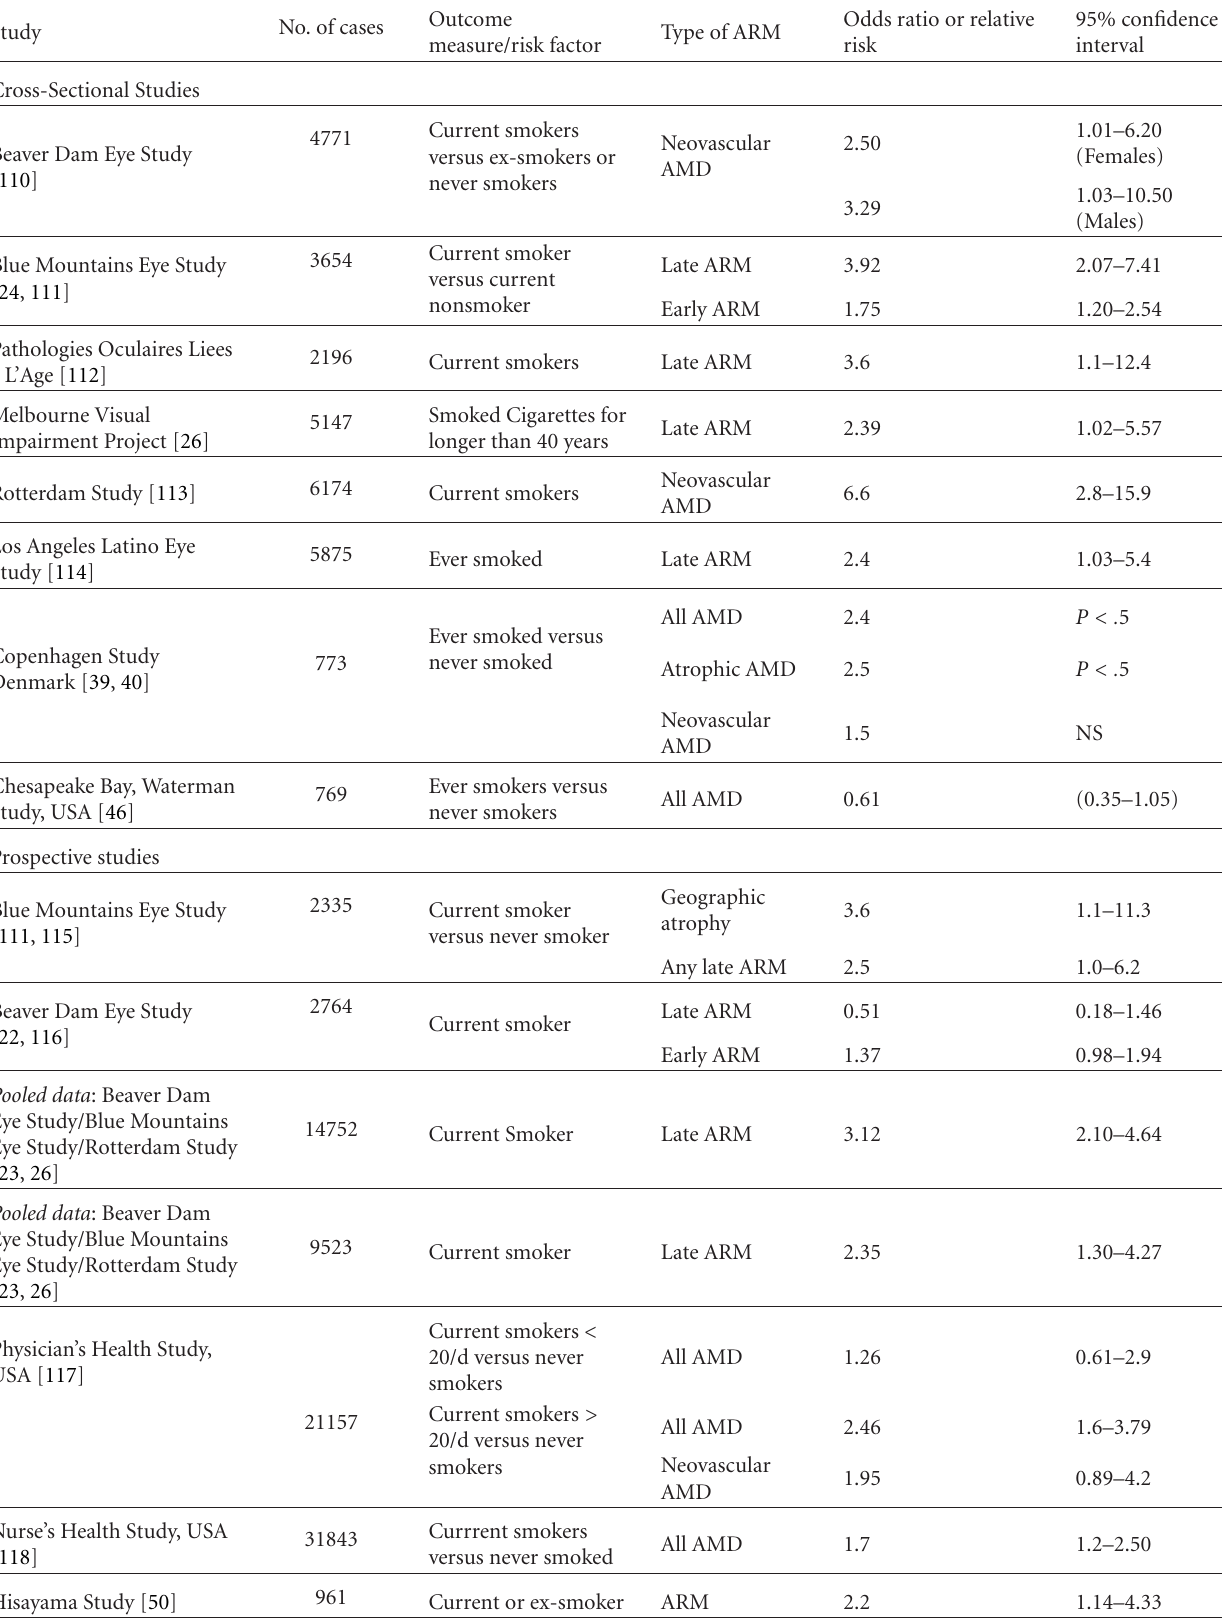
Table 3: Studies investigating the relationship between tobacco use and risk for